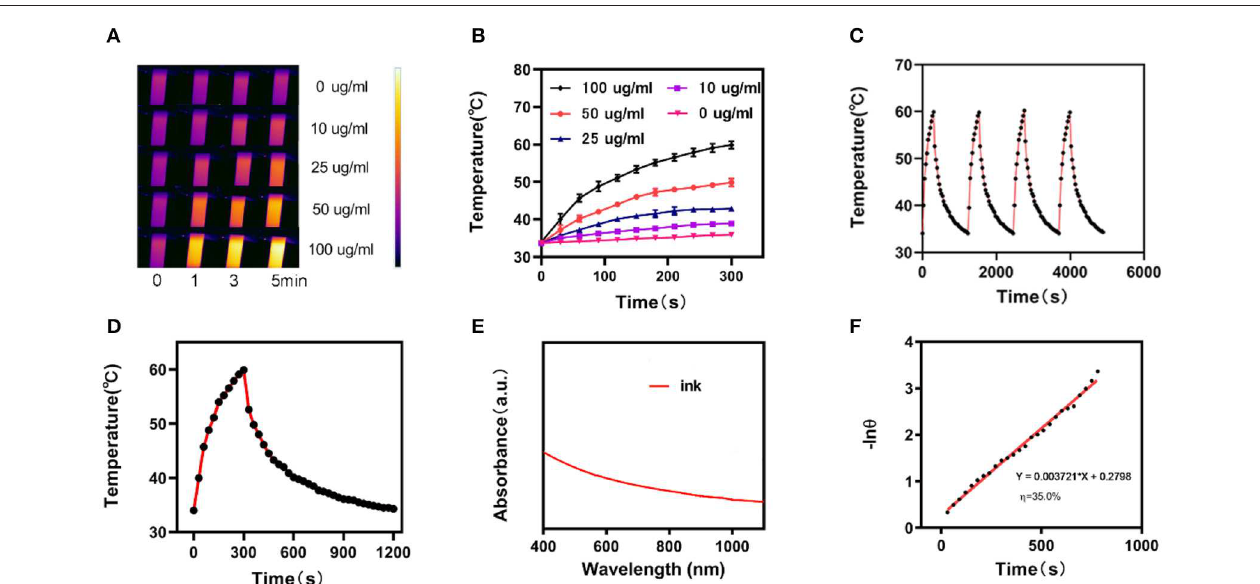
FIGURE 2 | (A) Infrared thermographic maps of ink solution in the centrifuge tube upon NIR laser irradiation for 0–5min. (B) Temperature increase for the different ink concentrations upon laser irradiation at 1,064nm and 1 W/cm 2 for 5min. (C) Temperature variation of an ink solution at 100 mg/mL under cyclic laser irradiation during which the laser is on for 20min in each cycle. (D) Temperature profile of an ink solution at 100 mg/mL upon heating when the laser is on and subsequent cooling once the laser is turned off. (E) UV-visible-NIR absorbance spectrum of an ink solution. (F) Calculation of the time constant for the heat transfer using a linear regression of the cooling profile.